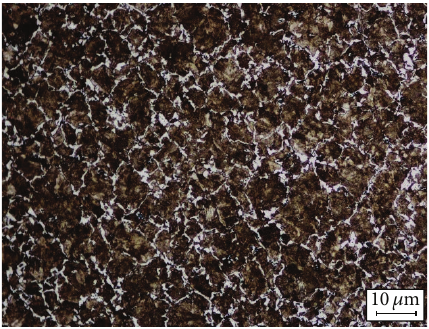
Figure 2: Microstructure of microalloyed steel tube